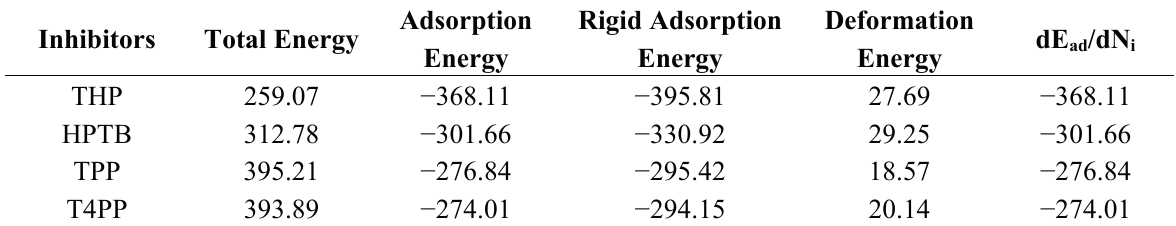
Table 5. Outputs and descriptors calculated by the Monte Carlo simulation for adsorption of THP, HPTB, TPP and T4PP on Fe (110) surface (in kcal/mol).